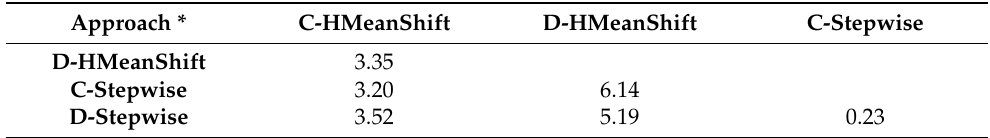
Table 4. Paired McNemar’s tests between the results using single-step HMeanShift and the stepwise approach with either a constant or dynamic kernel. The chi-square Z values are presented in the